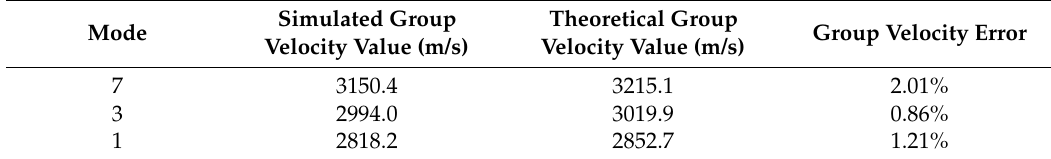
Table 5. Group velocities of modes.